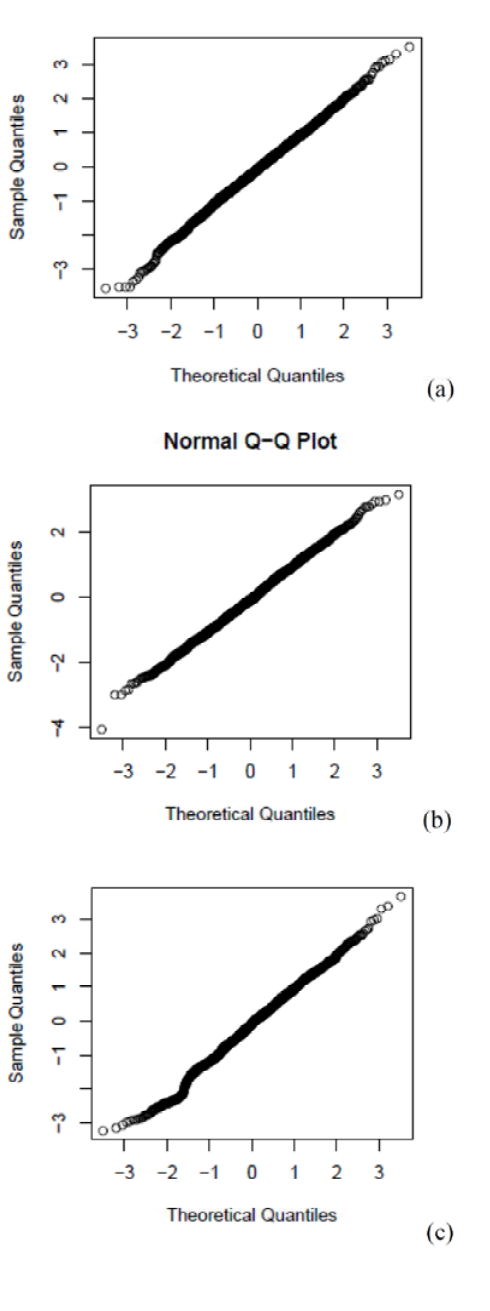
Figure A10. Normal Q-Q plot for the generalised additive Poisson time-series regression models (entire year): RD ( a ), CVD ( b ) and CBD ( c ) mortality in Cape Town, South Africa during 2001–2006. Adjusted for the 2-day cumulative average of PM long term seasonal trends, public holidays, day of the week, 2-day cumulative averages of 24-h apparent temperature, wind and rain. K = 30 for time, i.e.